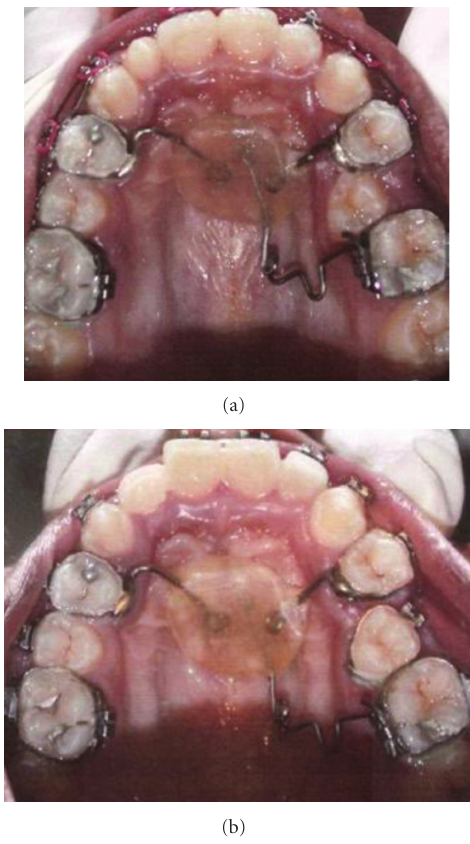
Figure 4: Unilateral molar distalization appliance used to align the impacted canine and 2nd premolar on right side.